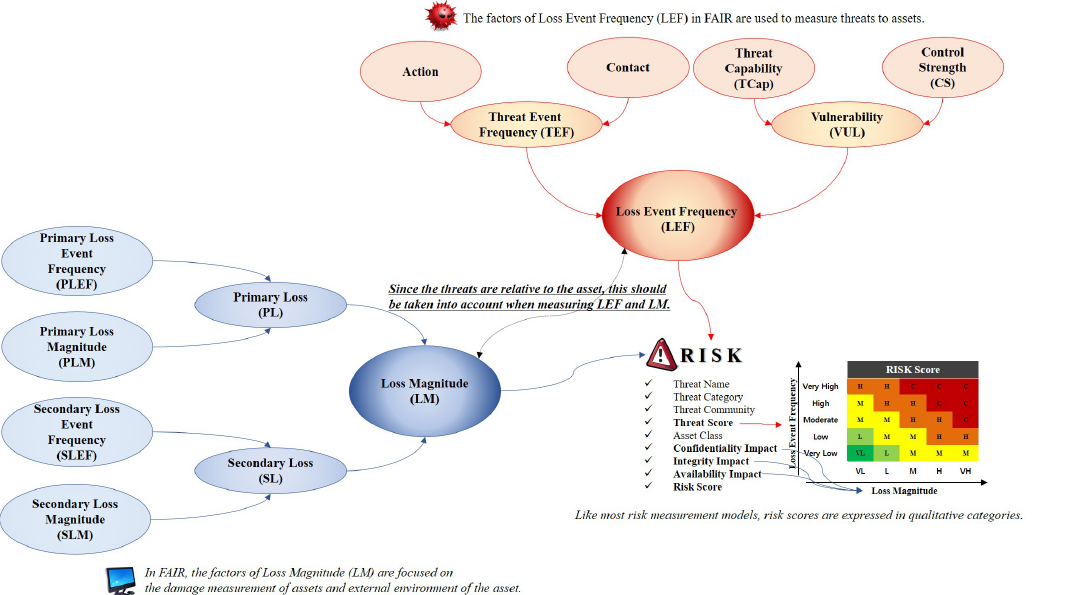
Figure 2. FAIR model is used to measure risk based on likelihood and probability, and consists of LEF and LM factors that represent threats and damage to assets,